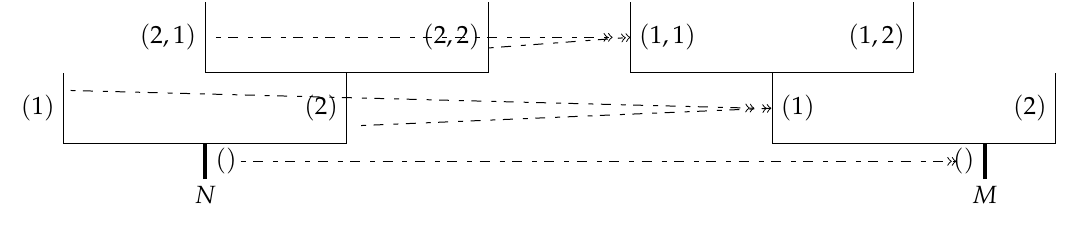
Figure 5. The relationships between domain and range of f are shown by dotted Fig5. The relationship between domain and rang of f are shown by doted lines.